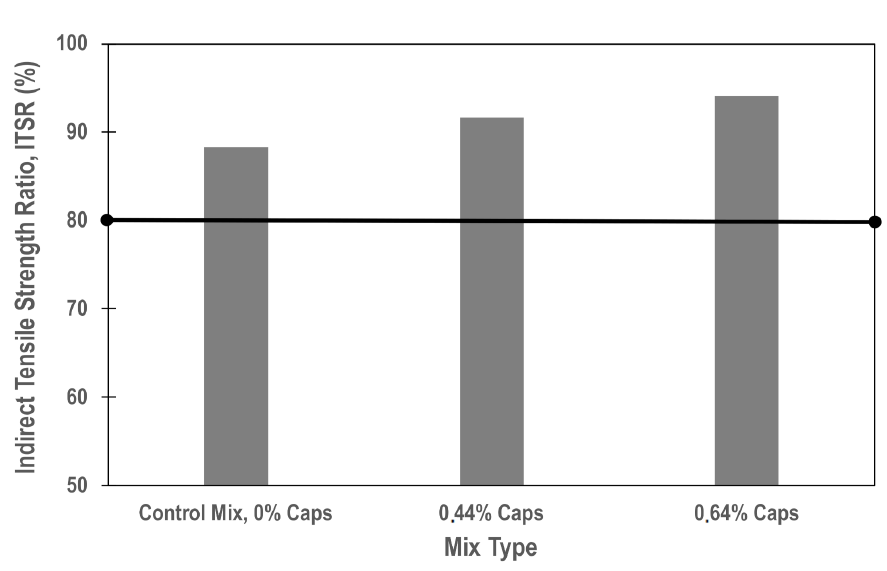
Figure 4. Water sensitivity test